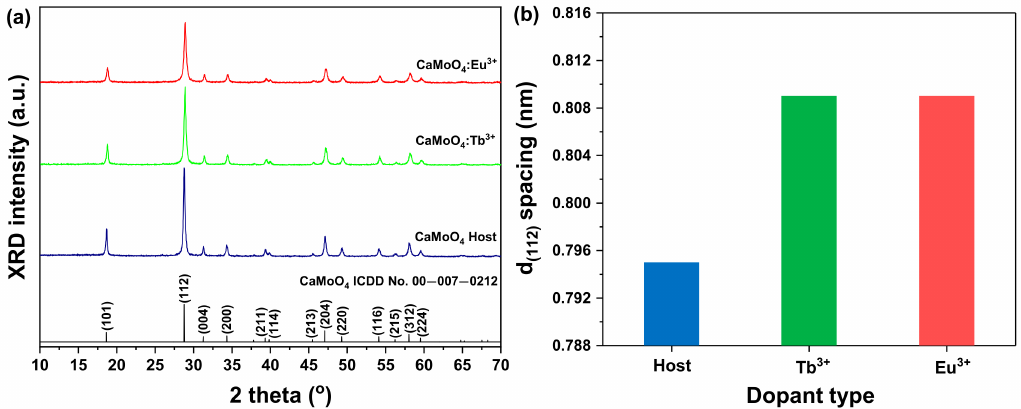
Figure 2. ( a ) XRD patterns and ( b ) d (112) spacing of CaMoO 4 and CaMoO 4 :RE 3+